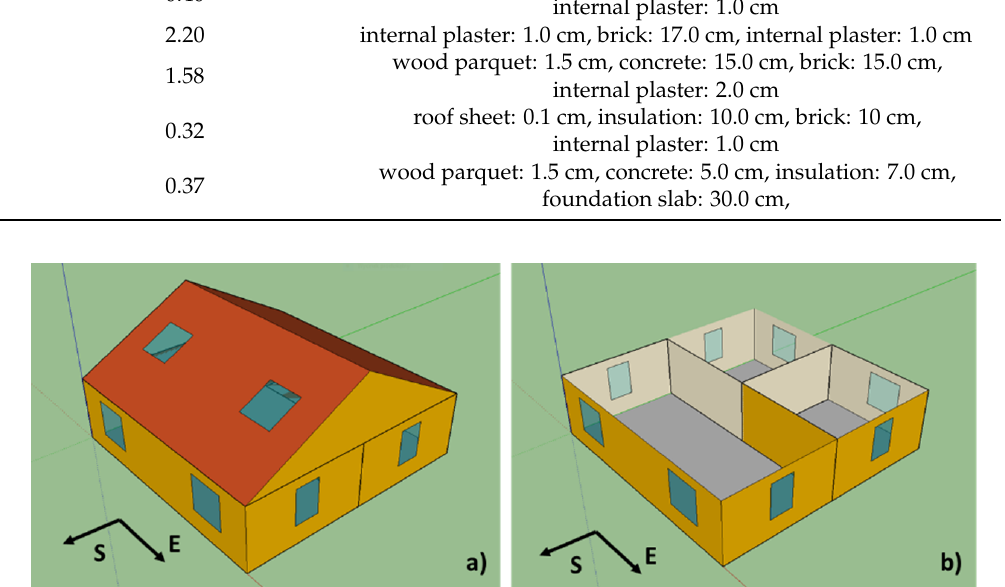
Figure 3. Building structure: ( a ) outside and ( b ) inside.